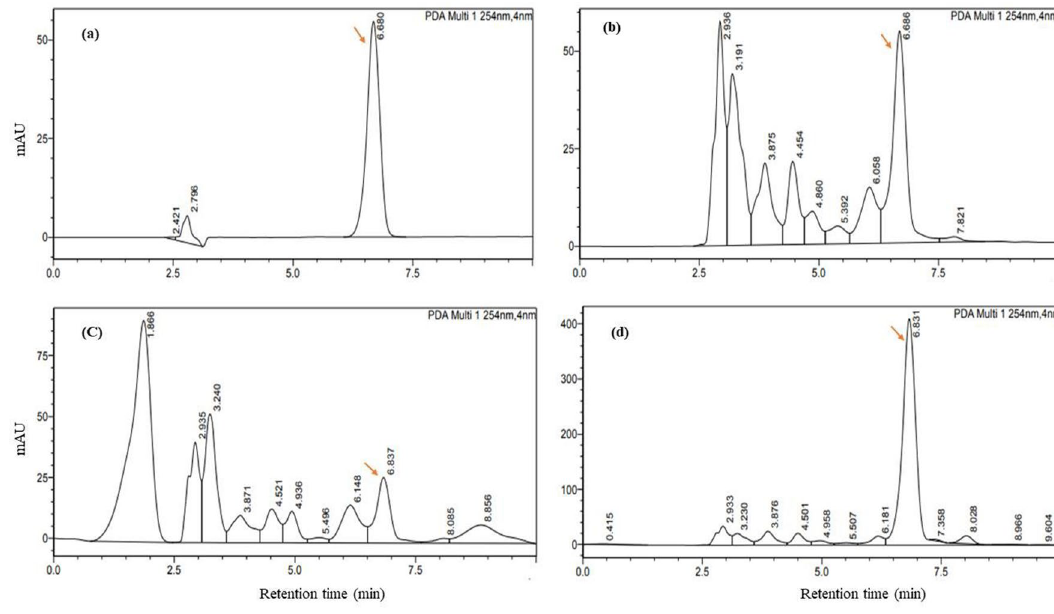
Figure 4. Quantification of IAA by HPLC. Chromatograms of standard (50 µg mL −1 ) IAA ( a ), and IAA in